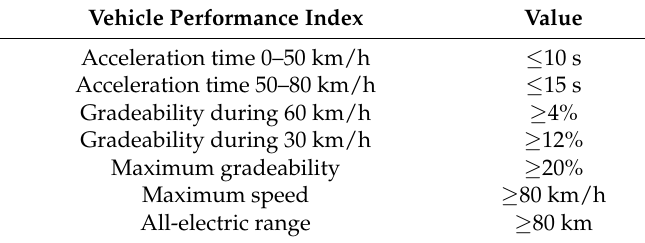
Table 4. Vehicle performance requirements.